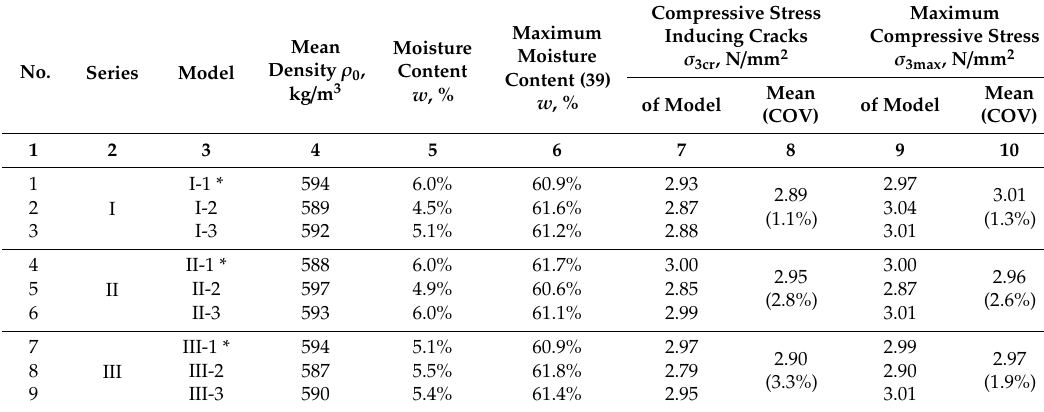
*—models, for which the propagation of ultrasonic waves c p was measured.